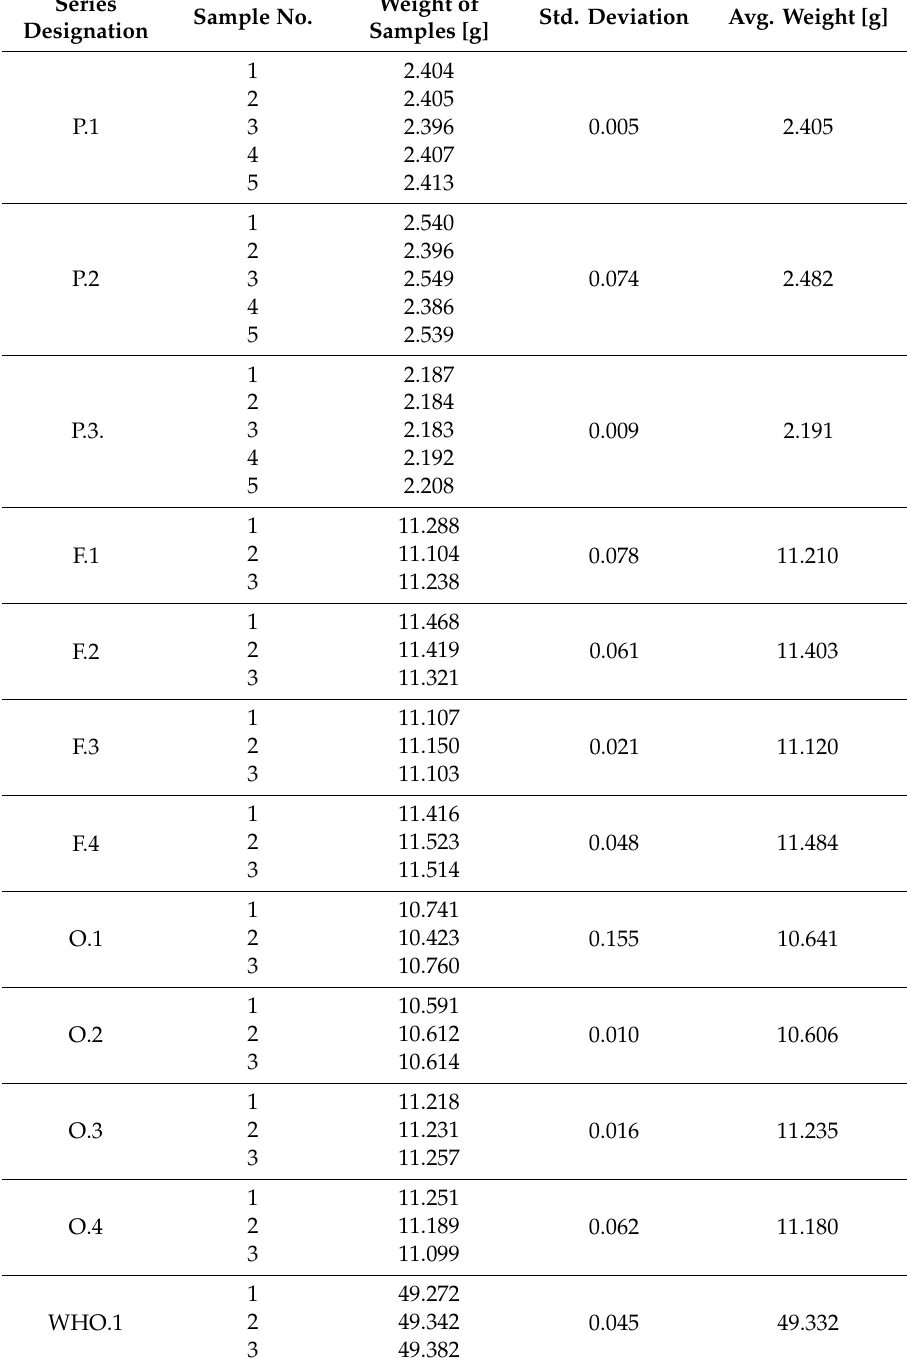
Table 2. Weight of the